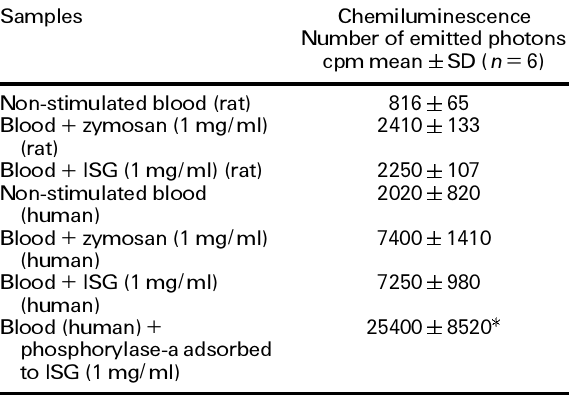
Table 4. Effect of insoluble glycogen (ISG) on the luminol ampli® ed chemiluminescence of neutrophils in whole hu- man and rat bloods. The results represent the mean values SD of three separate experiments wtih duplicated samples ( n = 6)